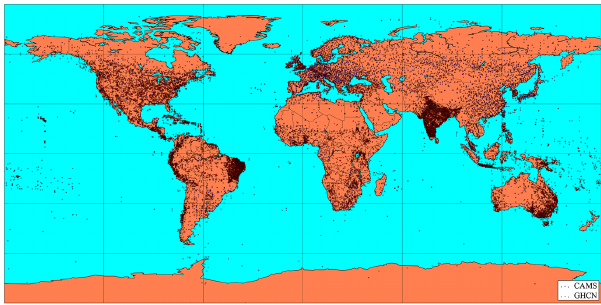
Figure 1. Visualization of the stations used to interpolate the grid points in the temperature